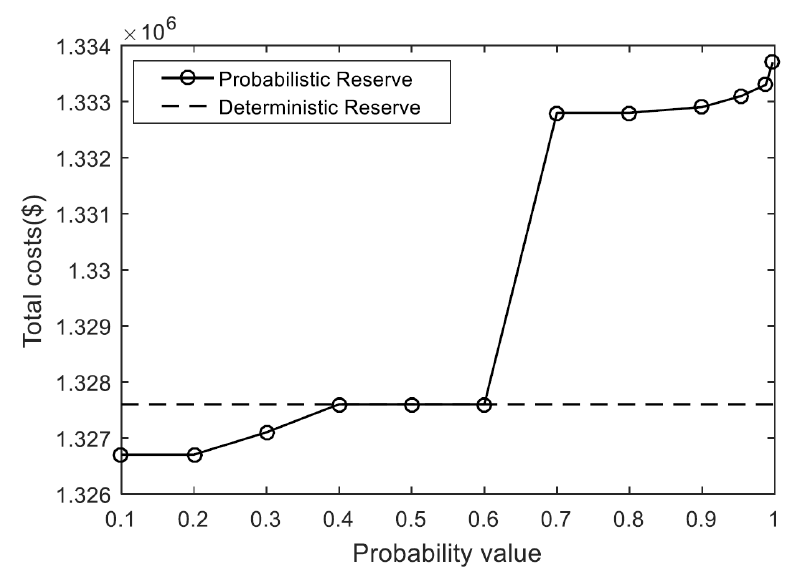
Figure 8. Total costs with different confidence